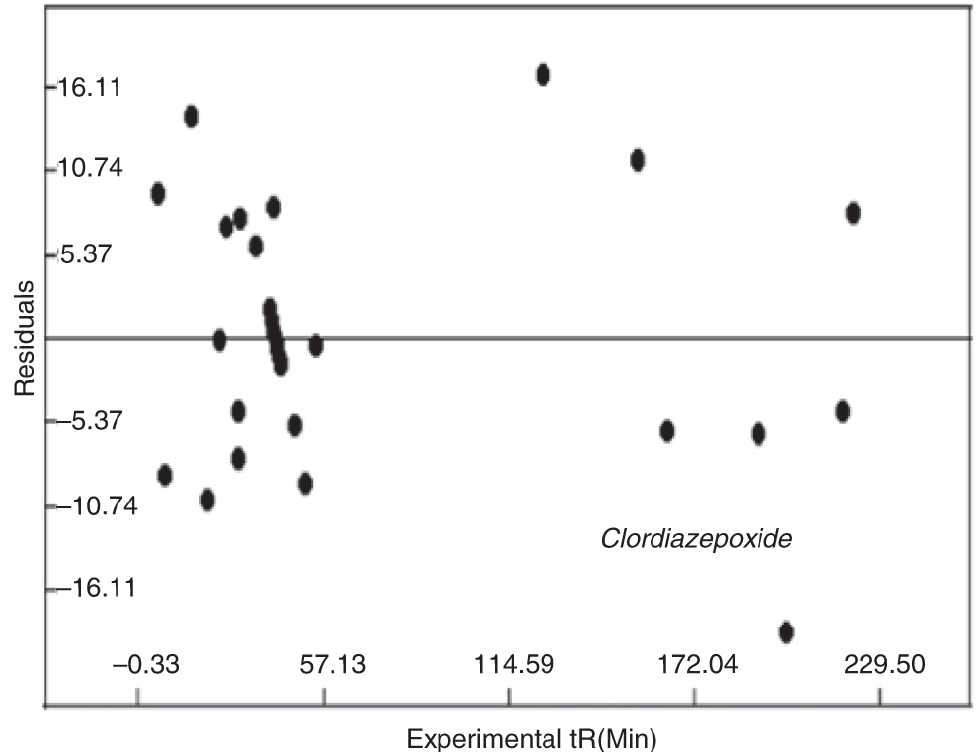
Figure 11: Residual plot: an example for predicted retention times according to the regression models generated after the application of face-centered cube response surface design (Hadjmohammadi and Ebrahimi 2004).